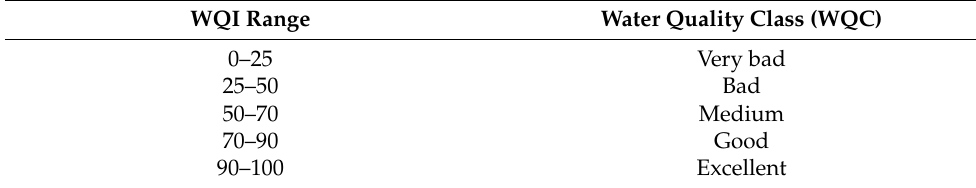
Table 2. Classification ranges